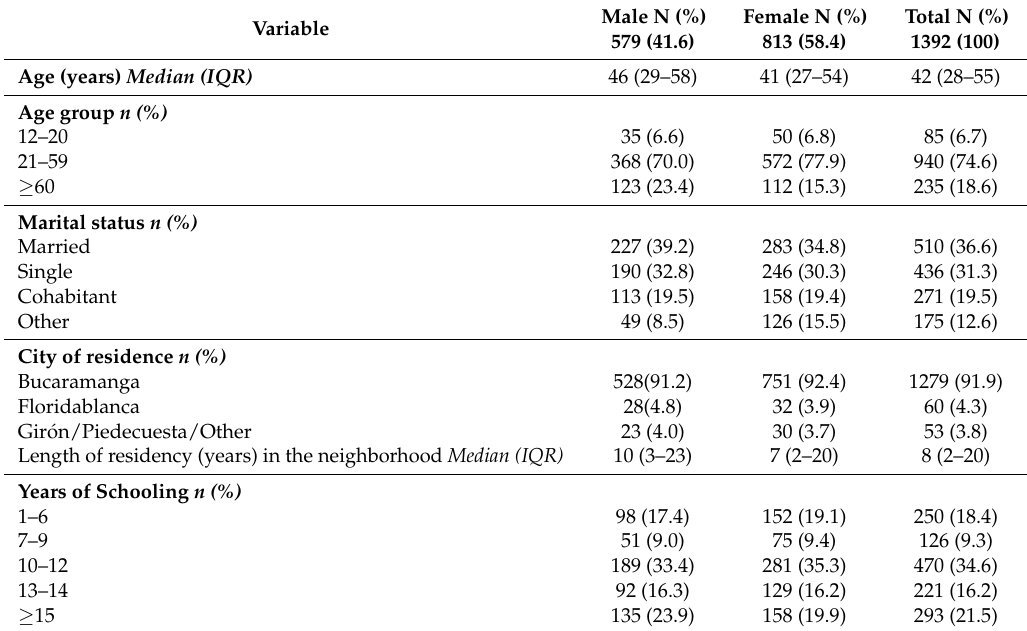
Table 1. Socio-demographic characteristics of park users (N =